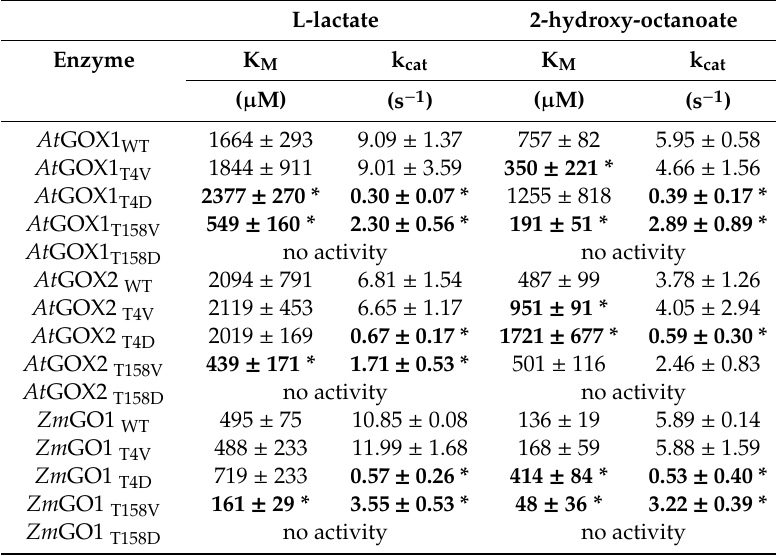
Table 3. E ff ect of selected phospho-site mutations on L-lactate and 2-hydroxy-octanoate dependent kinetic parameters of recombinant At GOX1, At GOX2 and Zm GO1. L-lactate 2-hydroxy-octanoate